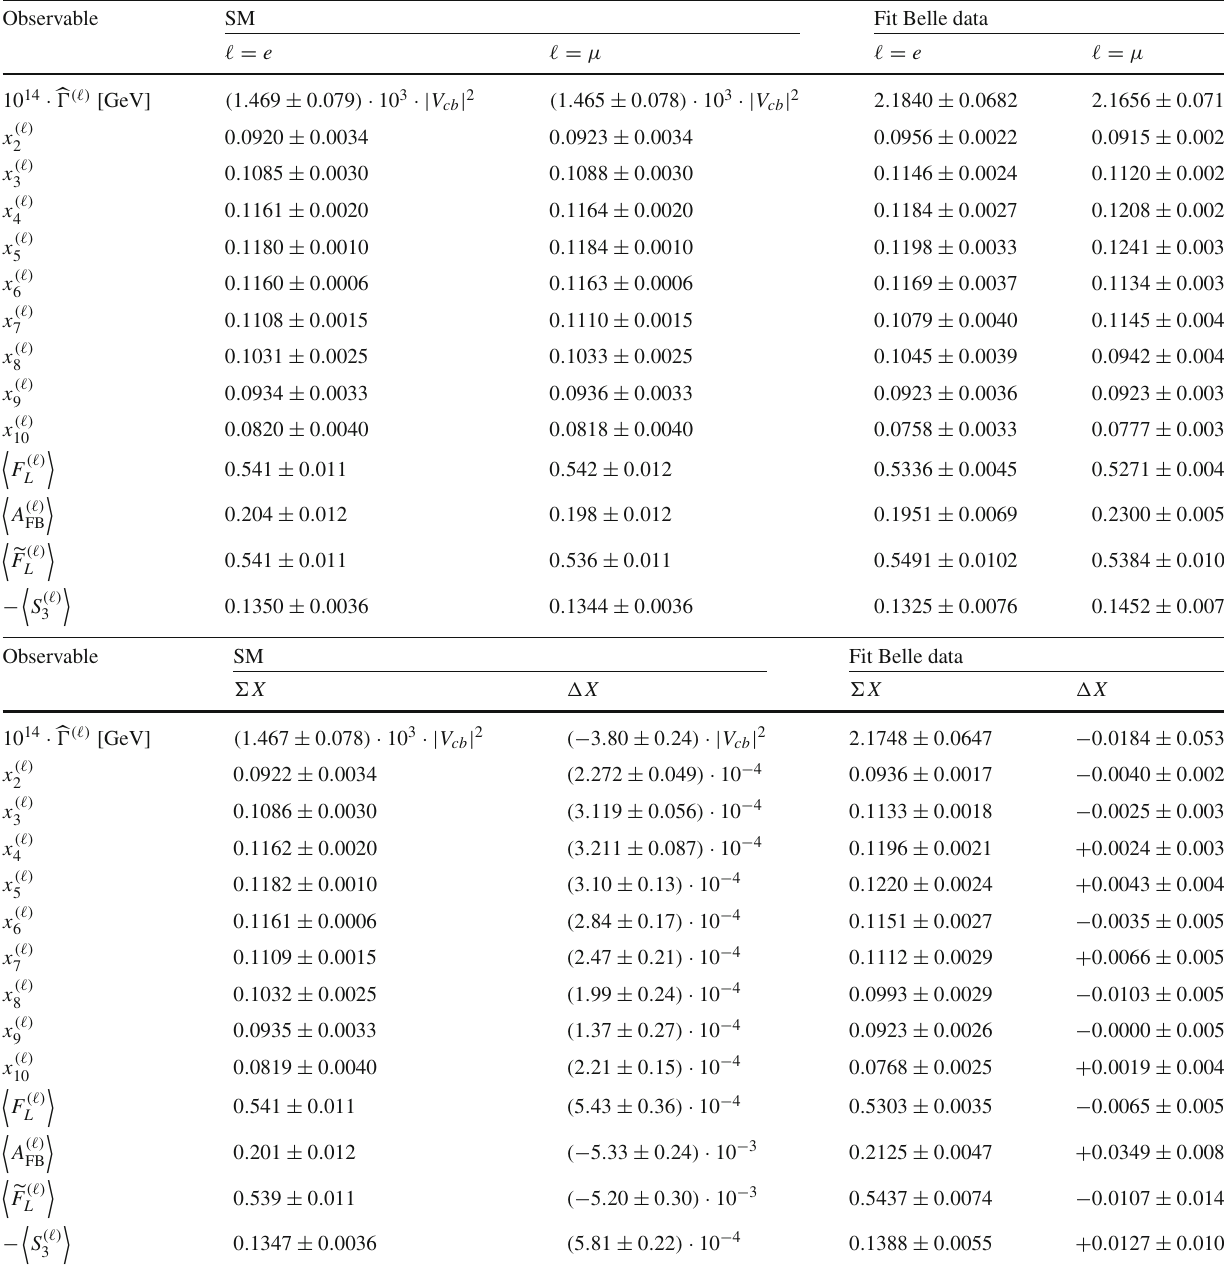
Table 3 The SM predictions of observables for (cid:2) = e and (cid:2) = μ , using the form-factor results [7], together with their values obtained from our fit to the Belle data [13]. For the prediction of the total rate, we leave the value of | V cb | unspecified